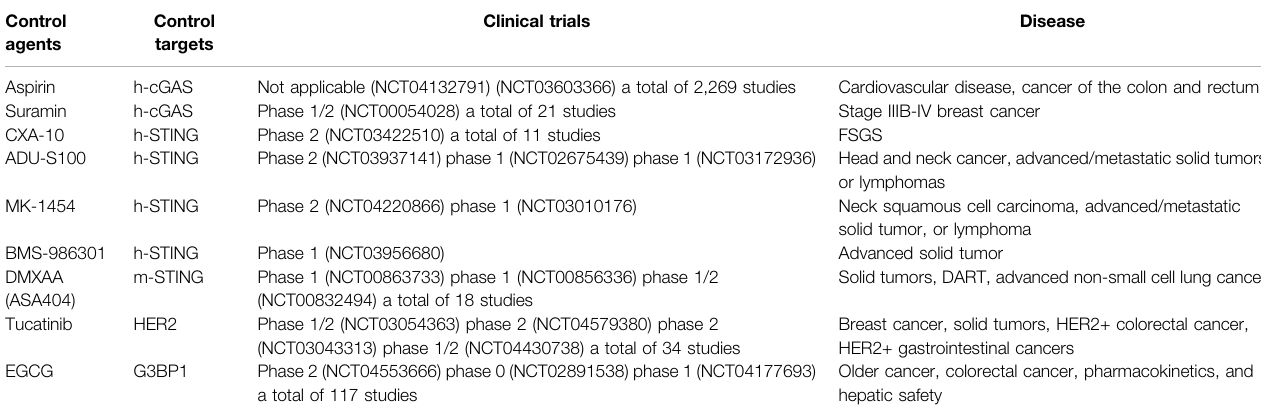
Clinical trials